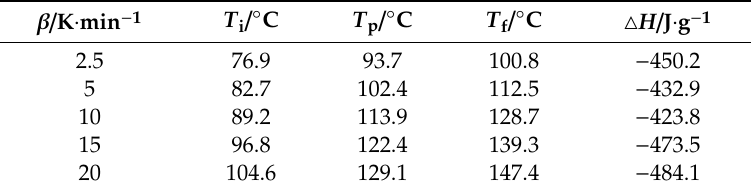
Figure 2. The DSC curves for AG-80/m-XDA curing system ( phr = 26) with different heating rates ( β = 2.5 K/min, 5 K/min, 10 K/min, 15 K/min, and 20 K/min) . Table 2. The characteristic temperatures and reaction enthalpy of AG-80/m-XDA curing system ( phr = 26) obtained from DSC curves with different heating rates ( β = 2.5 K/min, 5 K/min, 10 K/min, 15 K/min, and 20 K/min) .